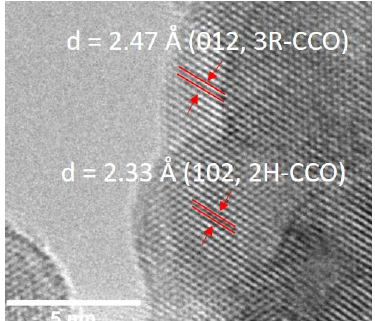
Figure 5. High resolution TEM (HR TEM) image of 5% Mg:CCO nanoparticle. Lattice spacings corresponding to the (012) reflection in 3R-CCO and the (102) reflection in 2H-CCO polytypes are indicated.